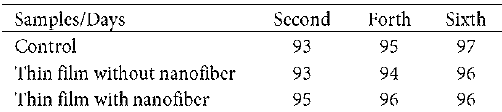
Table 4. Percentage of live fibroblast cells after 2, 4 and 6 Figure 8 . Fibroblast cells in DMEM on the films (A) with and (B) without nanofiber under inverted microscope, (C) Curves of percentage of live cells after 2, 4 and 6 days , (D,E) SEM image of fibroblast cells on the film containing nanofiber